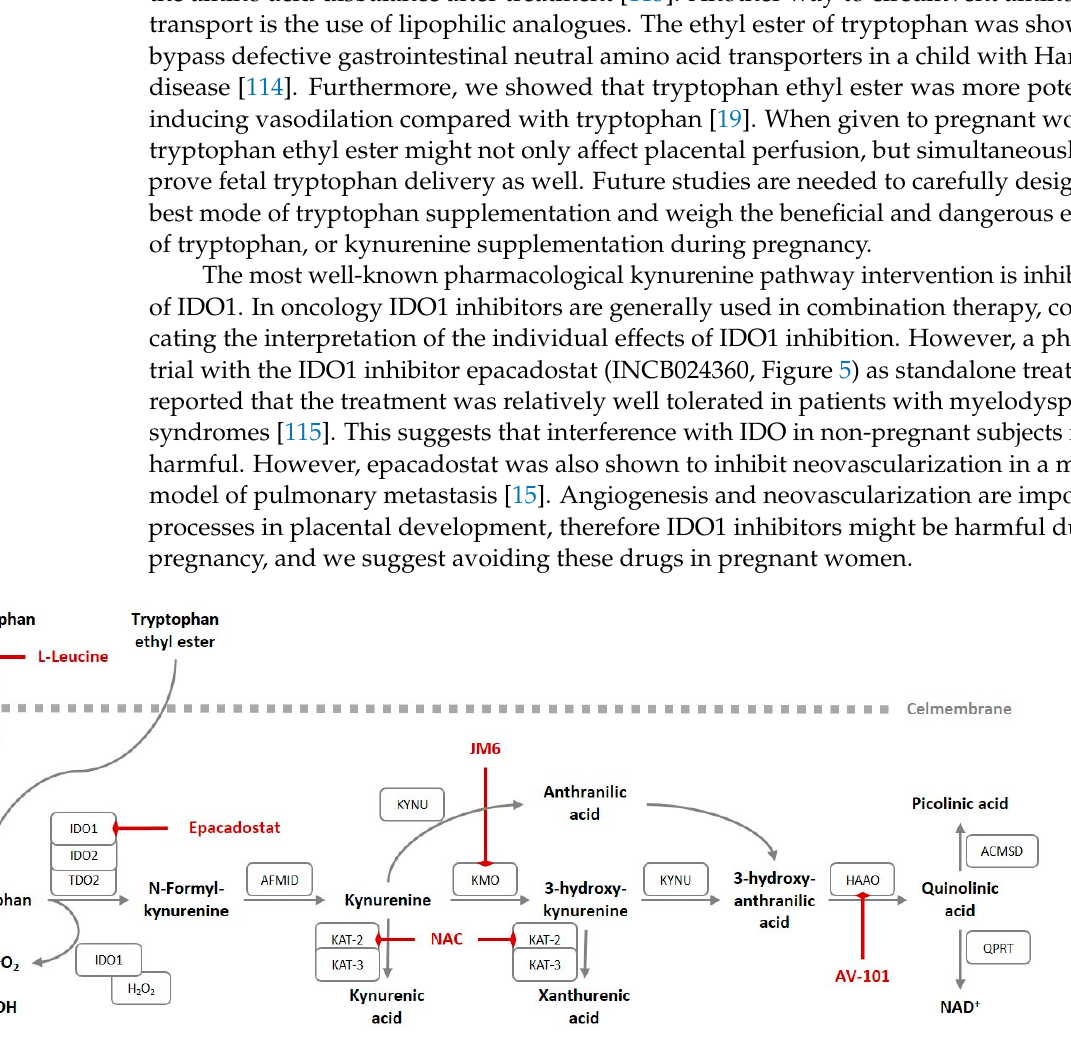
Figure 5. The kynurenine pathway with pharmacological interventions. L-Leucine is a natural competitor for Tryptophan transport by LAT1. The lipid soluble form of tryptophan, tryptophan ethyl ester, can circumvent the amino acid transporters. Epacadostat selectively inhibits IDO1. JM6 is an inhibitor of KMO. AV-101 (4-chlorokynurenine) is a prodrug of 4-chloro-3-hydroxyanthranilic acid, a potent inhibitor of HAAO. NAC ( N -acetylcysteine) inhibits KAT2, and the subsequent formation of kynurenic acid and potentially xanthurenic acid. IDO, indoleamine 2,3-dioxygenase; TDO, tryptophan 2,3-dioxygense; AFMID, arylformamidase; KAT-2, aminoadipate aminotransferase; KAT-3, kynurenine aminotransferase 3; KYNU, kynureninase; KMO, kynurenine 3-monooxygenase; HAAO, 3-hydroxyanthranilate 3,4-dioxygenase; ACMSD, aminocarboxymuconate semialdehyde decarboxylase; QPRT, quinolinate phosphoribosyltransferase; LAT, large neutral amino acid transporter.